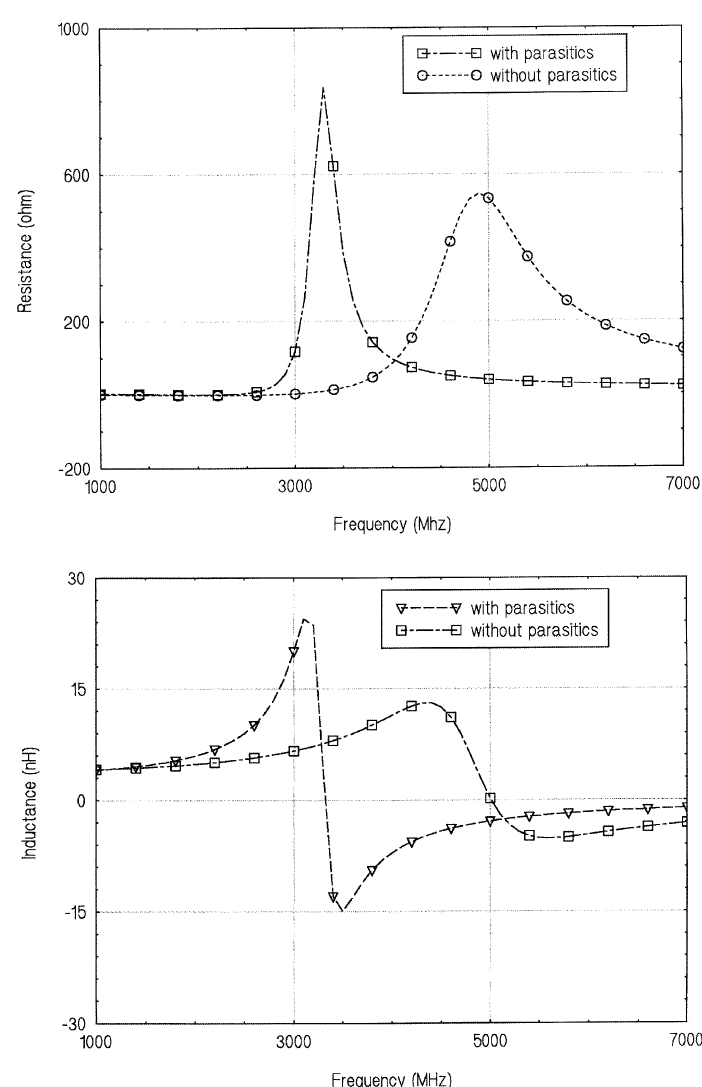
FIGURE 4 Series resistance and inductance of Khoury